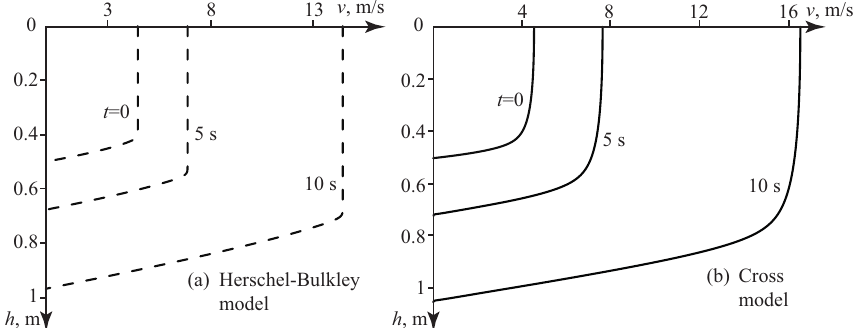
Figure 14. Velocity profiles at different instants for the laminar entraining flow of the Herschel–Bulkley fluid ( a ) and the Cross fluid ( b